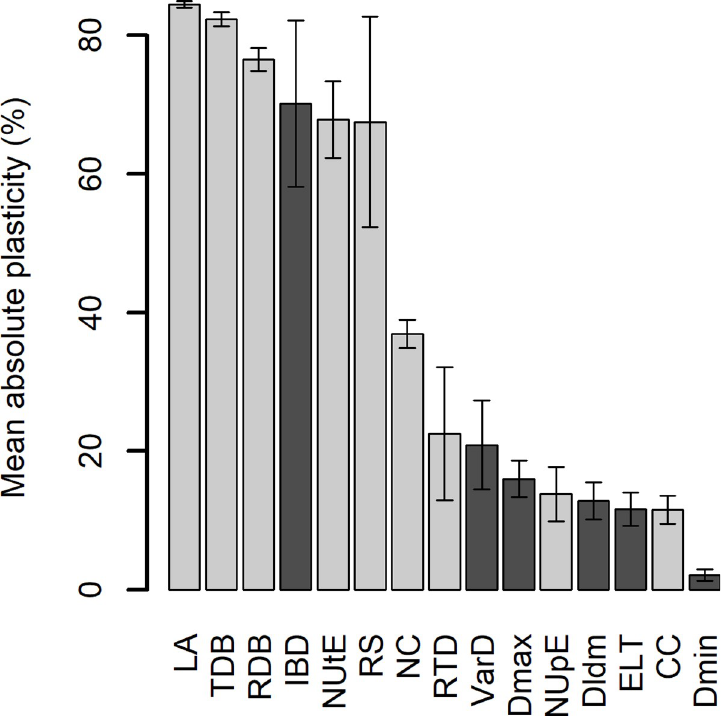
Fig 4. Absolute plasticity of the 15 measured traits in response to N limitation, averaged by pooling the eight genotypes. LA: Leaf Area; TDB: Total Dry Biomass; RDB: Root Dry Biomass; IBD: Inter-Branch distance; NUtE: Nitrogen Utilization Efficiency; RS: Root:Shoot Ratio; NC: Nitrogen Content; RTD: Root Tissue Density; VarD: Lateral root diameter variation; Dmax: Root maximal diameter; NUpE: Nitrogen Uptake Efficiency; Dldm: Root Hierarchy; ELT: Root elongation rate by root diameter; CC: Carbon Content; Dmin: Root minimal diameter. Dark bars represent RSA traits while light bars represent PA traits. Error bars are standard errors of the mean (n = 8).